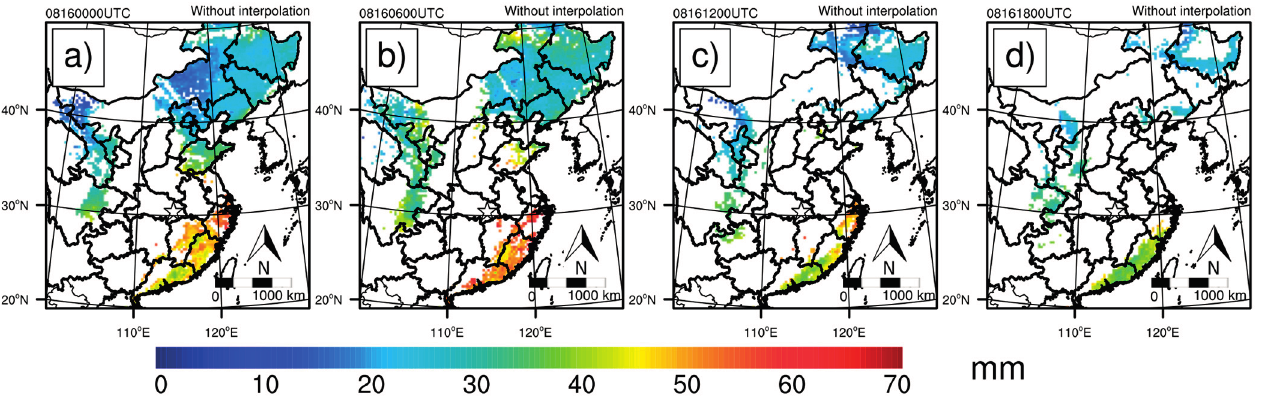
Figure 3. Time series of hourly original, reconstructed and GPS precipitable water vapor at “WHJF” site (30.5°N, 114.5°E, marked in Figure 4) in August 2008.